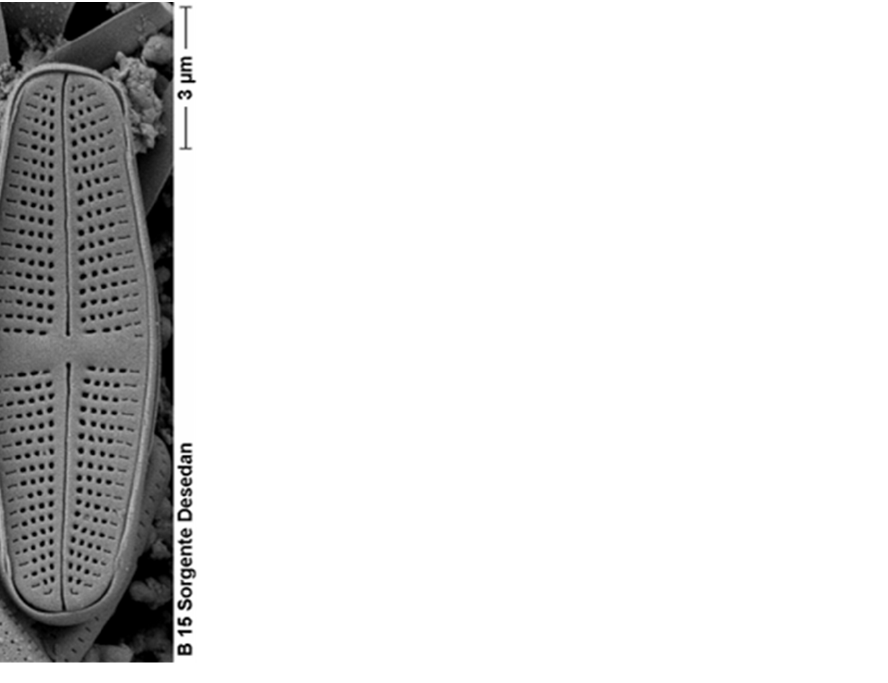
Figure 6. The diatom Achnanthidium dolomiticum Cantonati et Lange-Bertalot observed under a scan- ning electron microscope. This mainly epiphytic species (in springs typically found on bryophytes) is on the one hand characteristic of inland waters with above-average magnesium concentrations and on the other hand an excellent indicator of discharge fluctuations, an ecological factor particularly important for the monitoring of climate change.